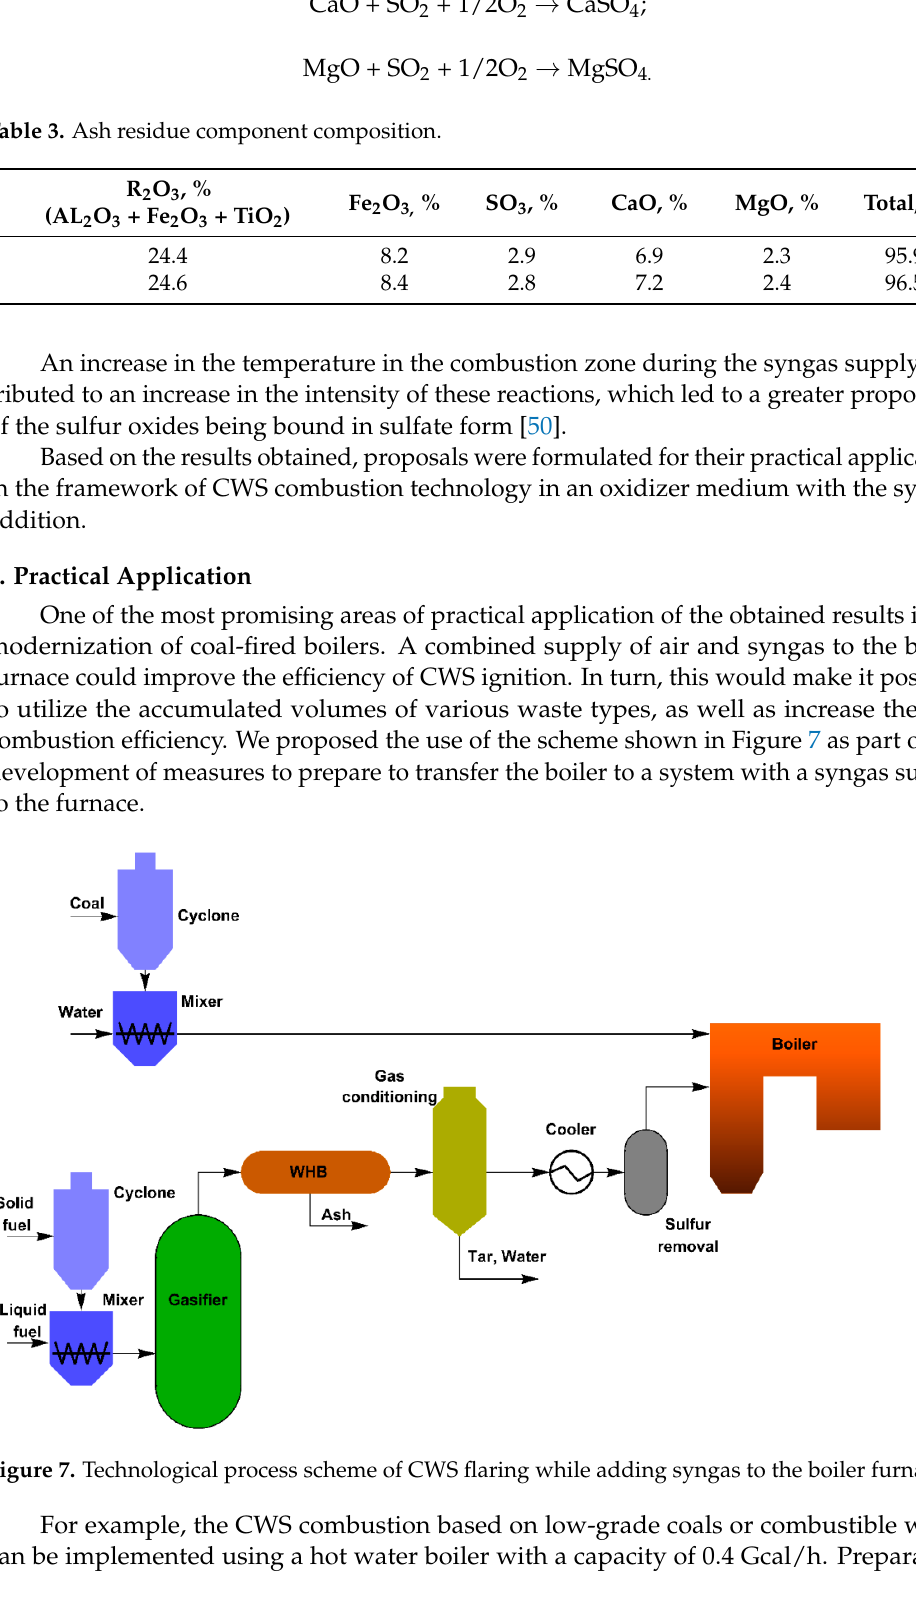
Table 3. Ash residue component composition.